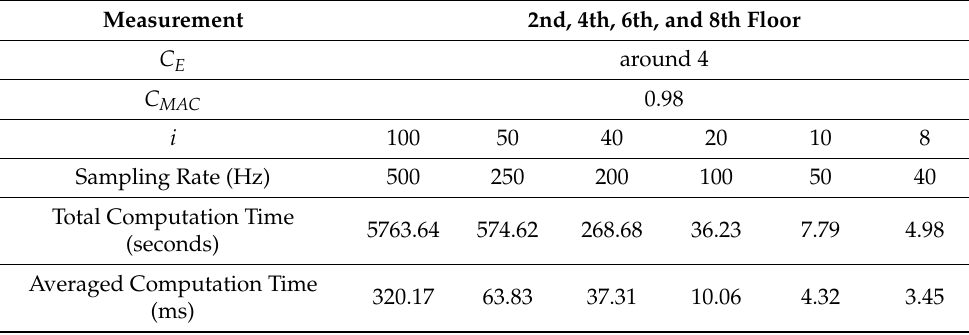
Table 3. The computation time over various sampling rates and a fixed α .